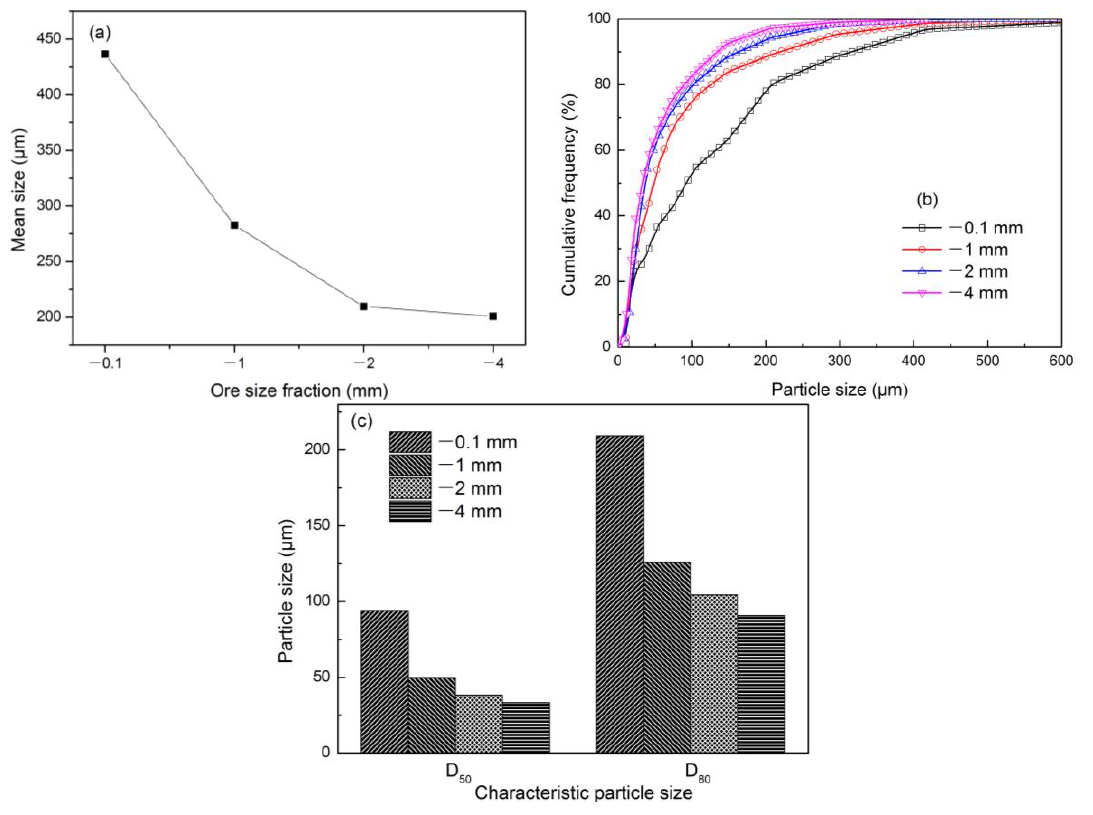
Figure 8. Effect of ore size fraction on iron particle size at 1523 K and 30 min: ( a ) Mean size; ( b ) cumulative frequency distribution; ( c ) characteristic particle size.